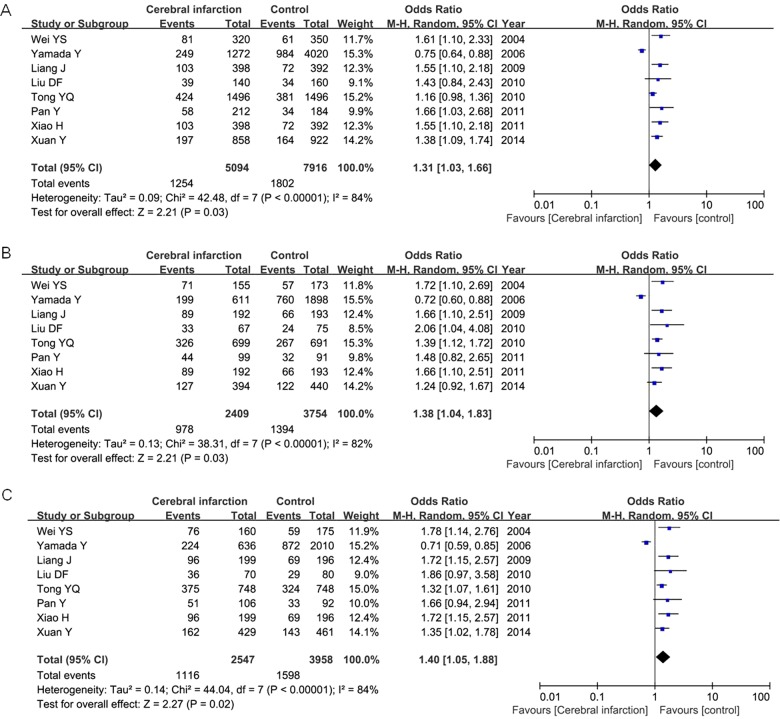
Meta-analysis of correlation of IL-6 −572C/G polymorphism in cerebral infarction risk under the allelic model (A: G versus C), heterogeneity model (B: CG versus CC) and dominant model (C: GG + CG versus CC) in the random-effect model.